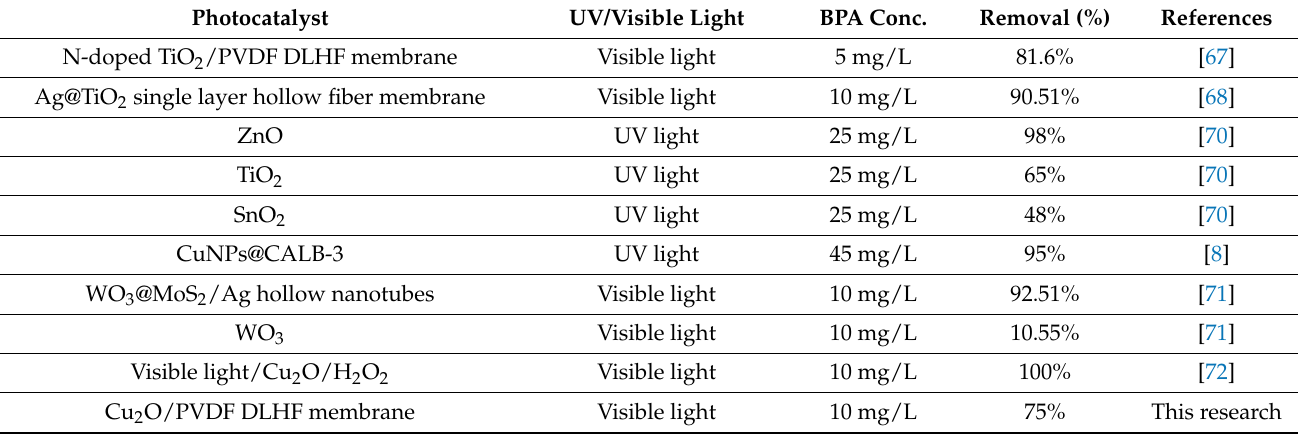
Table 5. Comparison between Cu 2 O/PVDF DLHF and other photocatalysts and BPA photodegradation. Photocatalyst UV/Visible Light BPA Conc. Removal